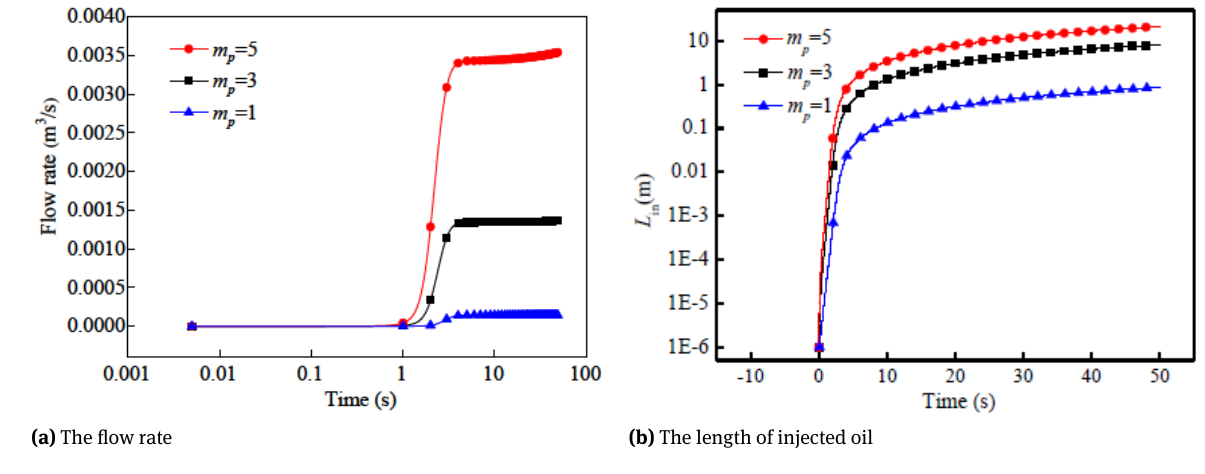
Figure 14: The flow rate and length of injected oil of Model 3